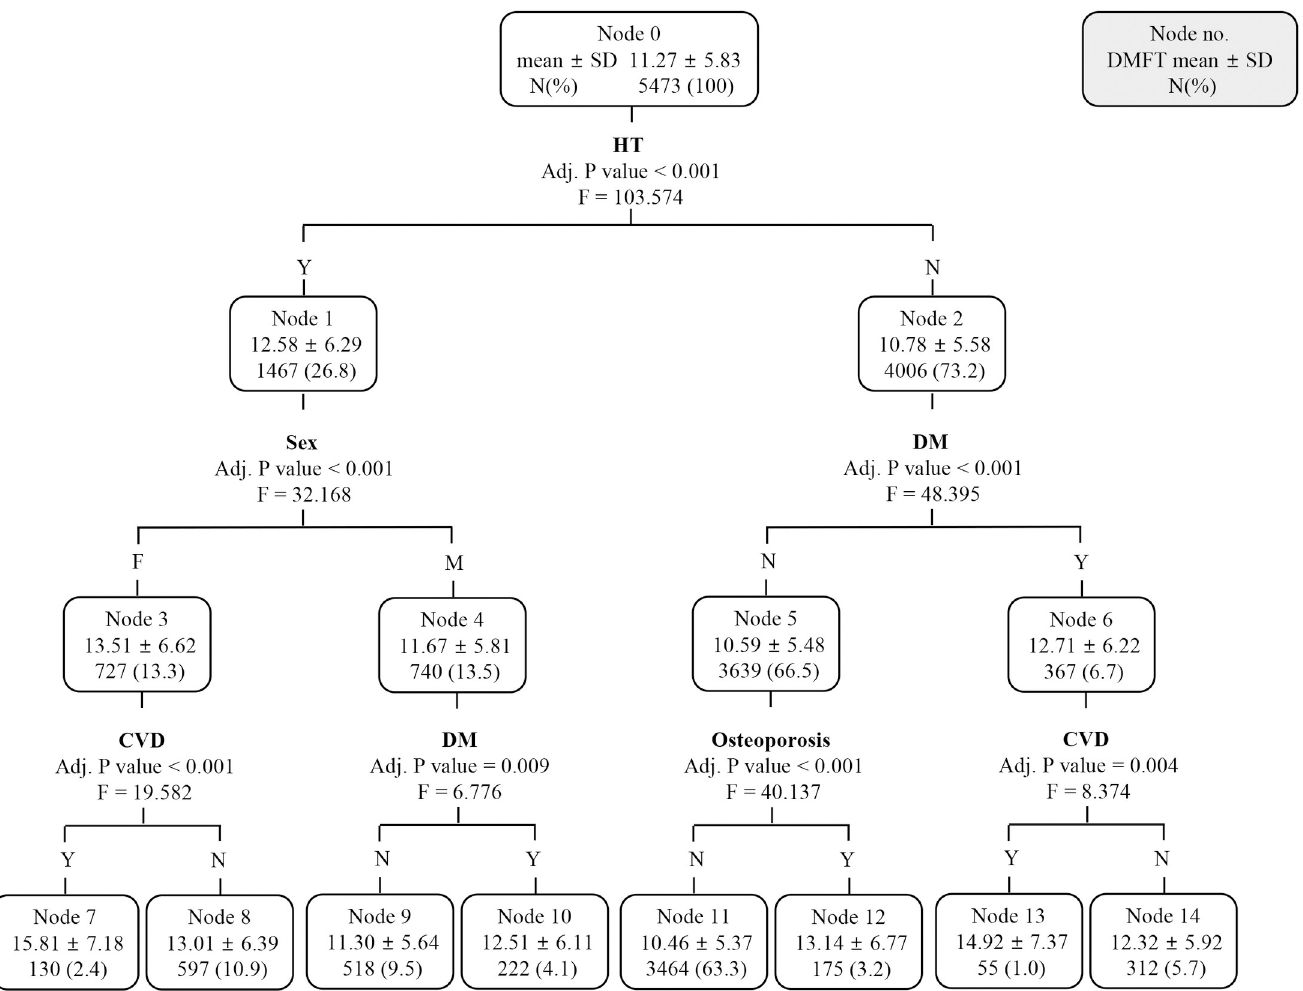
Fig 4. A chi-square automatic interaction detection classification tree analysis to identify the predictors related to the DMFT of subjects with DMFT score � 4.5; excluding age. Data were presented as mean ± standard deviation. HT, hypertension; F, female; M, male; DM, diabetes mellitus; CVD, cardiovascular